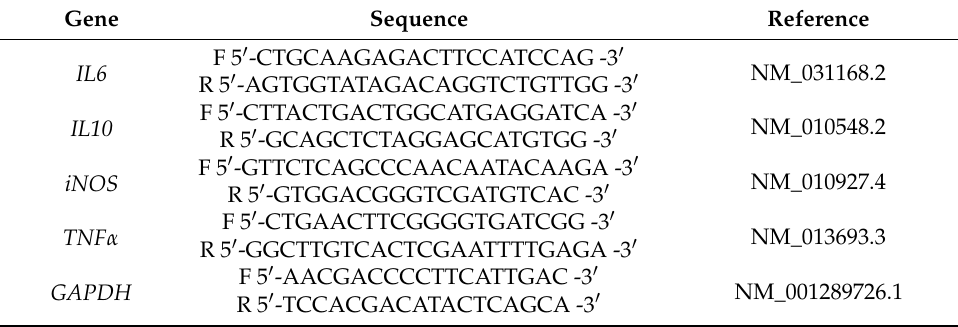
Table 2. Information of specific primers used for amplification in real-time PCR. Gene Sequence